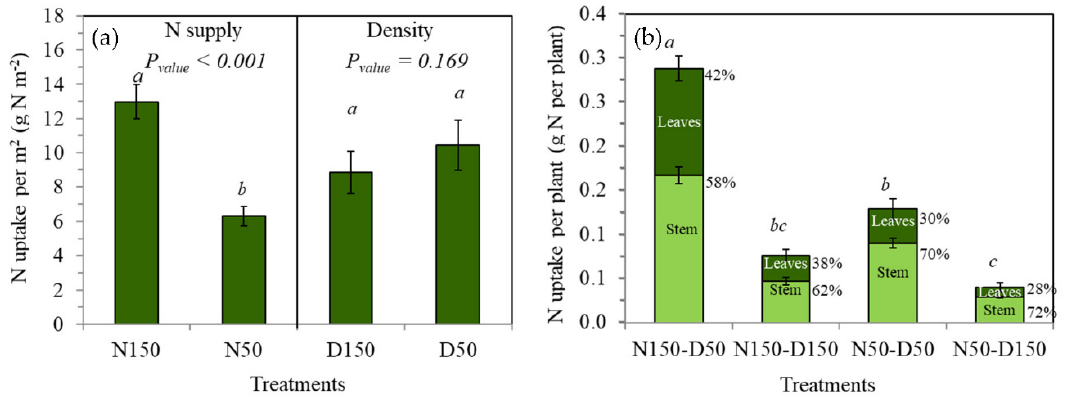
Figure 7. ( a ) N uptake per square meter, and ( b ) N uptake per plant and percentage of N in leaves and stems in response to N supply and plant population density at 7 days before flowering (BBCH 62). Different letters indicate significant differences across treatments ( p < 0.05), and vertical bars indicate the standard error of means.